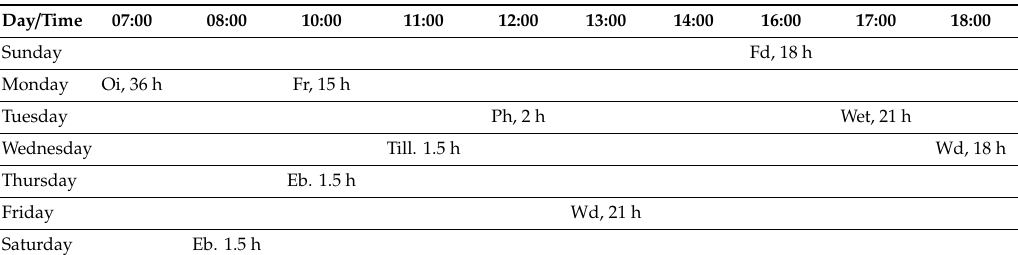
Table 2. The chronic mild stress (CMS) protocol.